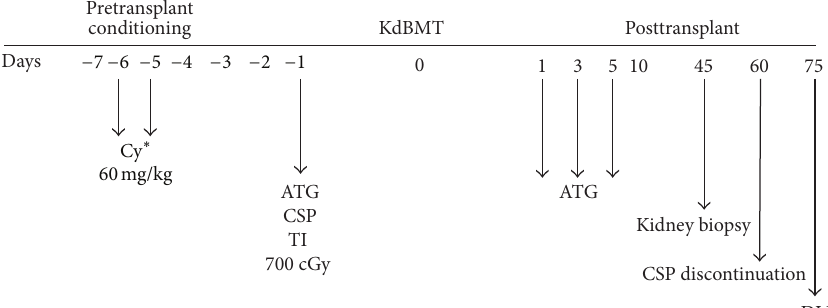
Figure 1: Combined HLA-matched bone marrow and kidney transplant. ∗ Hemodialysis 14 hours after each Cy dose. Cy: cyclophosphamide; ATG: equine antithymocyte globulin; CSP: cyclosporine; cGy: centigray; DLI: donor lymphocyte infusion; KdMBT: combined kidney and bone marrow